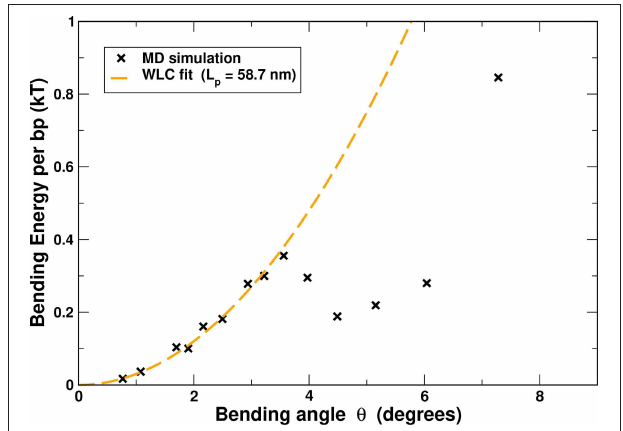
FIGURE 6 | The effective DNA bending energy, per base pair, as a function of the bending angle θ , inferred from all-atom MD simulations of uniformly bent DNA circles of variable lengths (50–400 bp). The statistical error bar is smaller than the symbol size. For reference, a WLC fit for small angle bends (up to ≈ 3.5 ◦ , dashed line) is shown; the fit yields a persistence length of 58.2 nm ( ≈ 172 bp), reasonably close to the experimental value of ≈ 50 nm ( ≈ 150